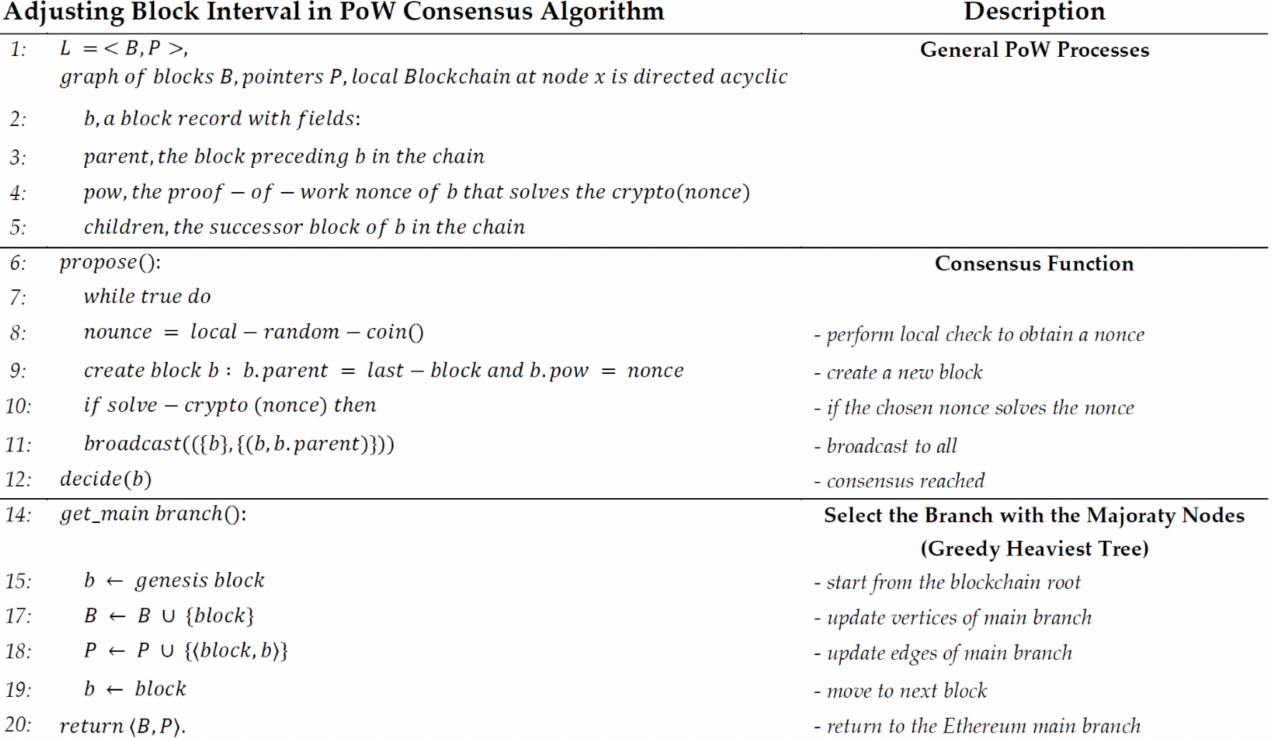
Figure 2. Adjusting Block Interval in PoW Consensus